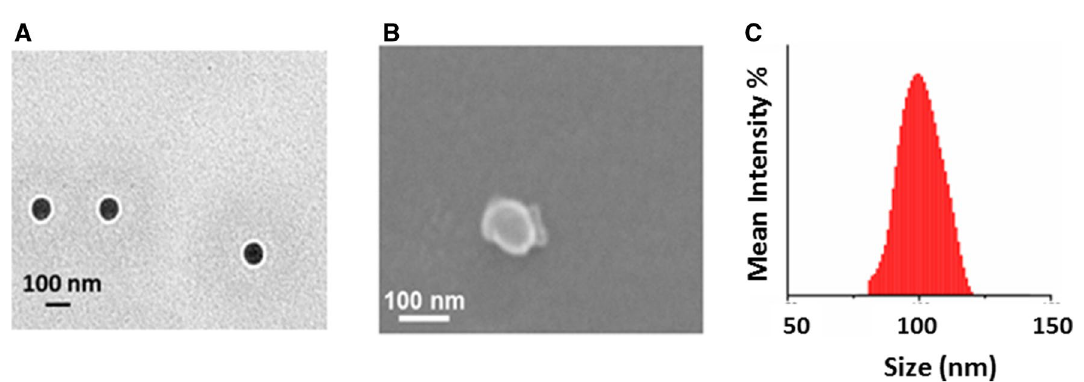
Figure 7. Aqueous self-assembly of the amphiphilic triblock copolymer P2L. TEM image ( A ); SEM image ( B ) and, particle size distribution by DLS ( C ).